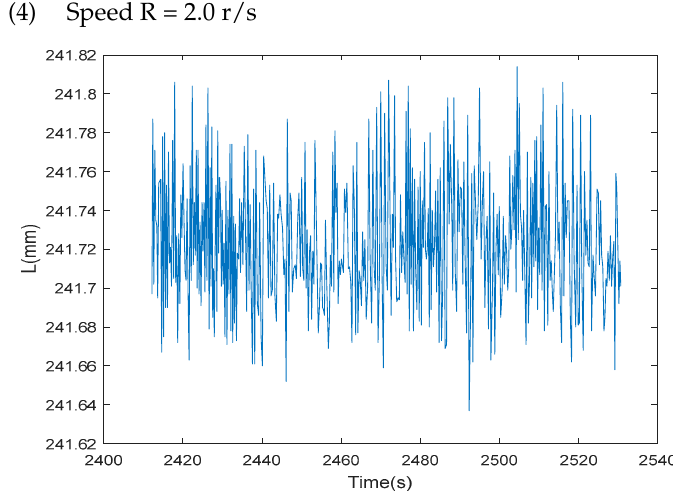
Figure 13. Measurement results of the distance between two targets at 1 r/s. (4) Speed R = 2.0 r/s